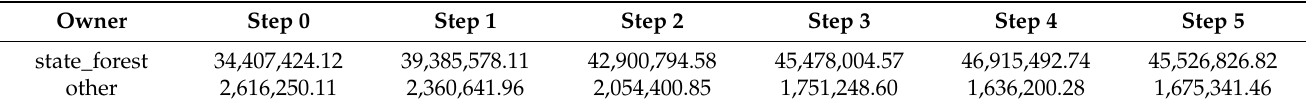
Table A4. Results from calculations conducted in EFDM software. Drain [m 3 ] volume aggregated